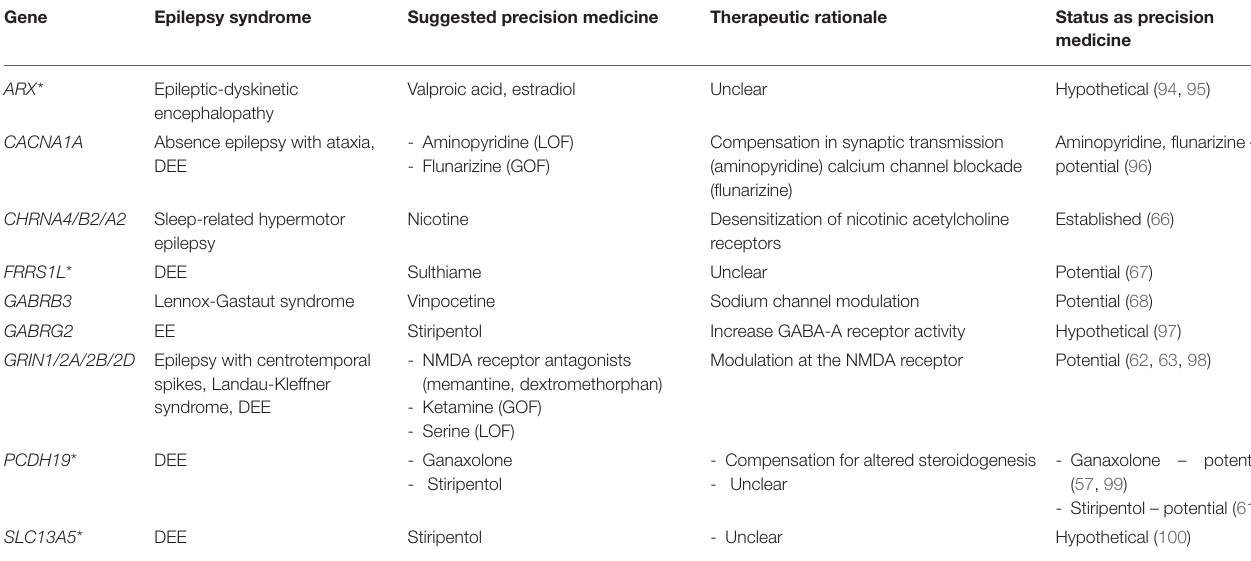
TABLE 4 | Repurposed medications for monogenic